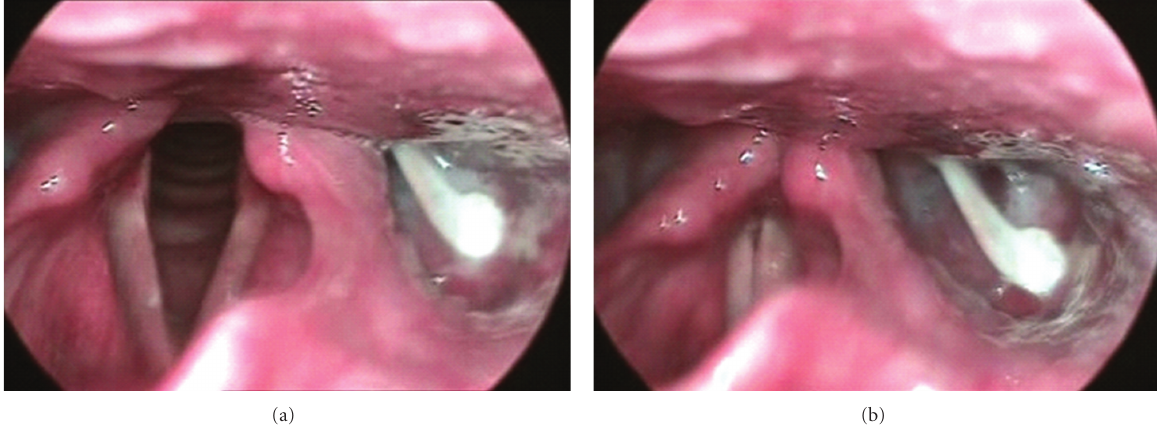
Figure 1: The impacted chicken bone is clearly identified in the left pyriform fossa; (a) laryngeal view during respiration, (b) laryngeal view during phonation.